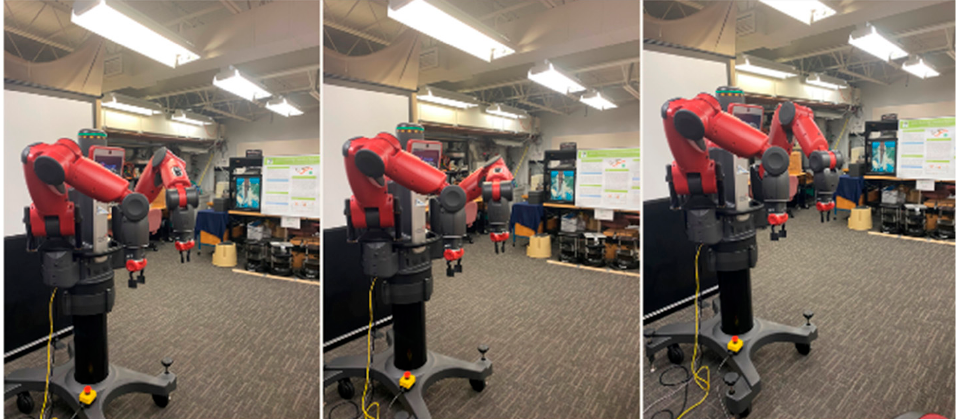
Figure 6. Baxter’s left-arm in joint con fi gurations of runs 1, 2 and 3 (in left to right order).